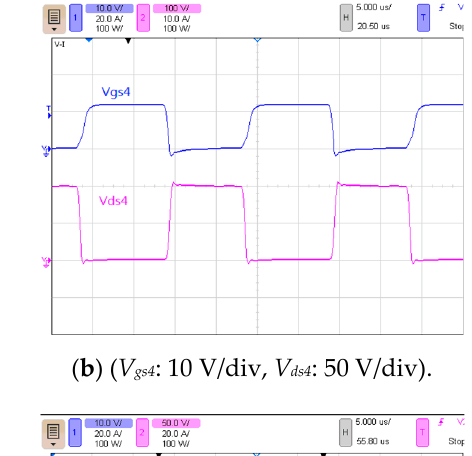
Figure 13. Measured waveforms under Stage 3 at half load: ( a ) switch S 3 waveform, ( b ) switch S 4 waveform, ( c ) current waveform of transformer, and ( d ) switch S 2 waveform and charging inductor current waveform.